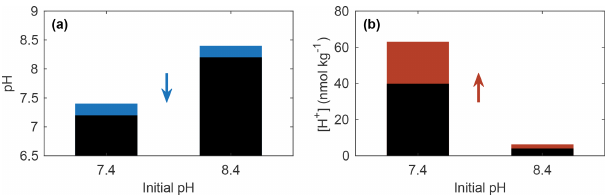
Figure 1. (a) A 0.2 unit decrease in pH (blue portion of bars) equates to (b) a 58% increase in [H + ] (red portion of bars) for both initial pH values of 7.4 and 8.4. The absolute change in [H + ] depends on the initial